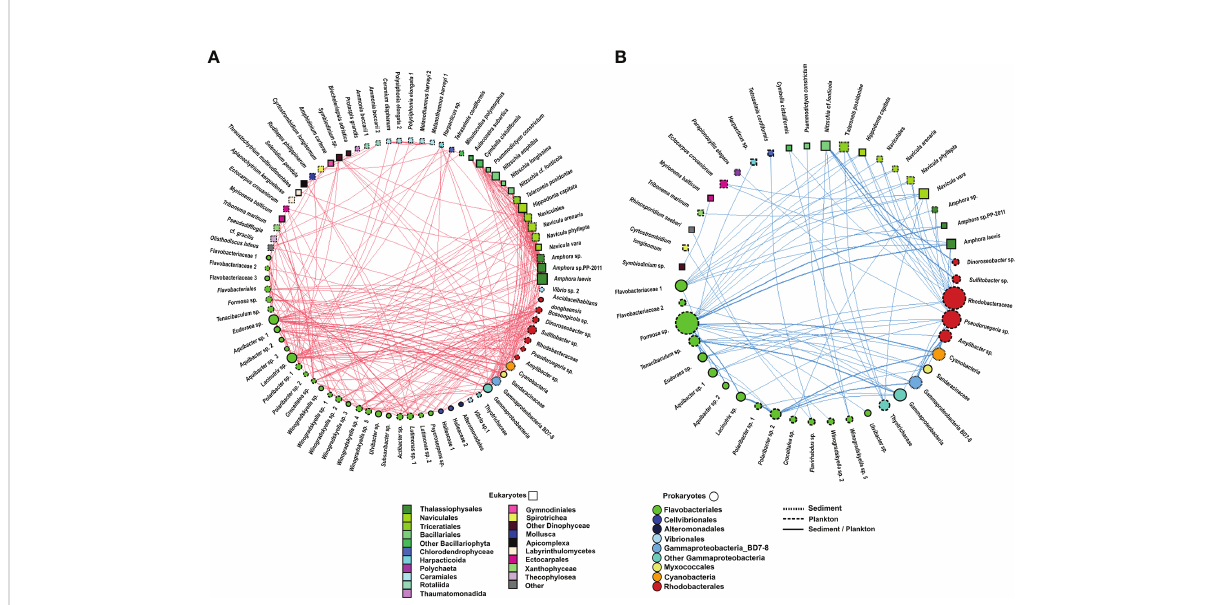
FIGURE 8 Undirected network that represents all links among organisms (prokaryote – prokaryote, eukaryote – eukaryote, and eukaryote – prokaryote). All signi fi cant correlations (p value <0.01) were represented. (A) Positive correlations and (B) negative correlations. The size and colour of the nodes represent the degree and taxonomic group, respectively. The shape of nodes represents whether the organism is a eukaryote (square) or prokaryote (circle). The type of node lines represents the environmental compartment (sediment, plankton, or both of them) on which each OTU is more representative in terms of percentage of total prokaryotic reads.